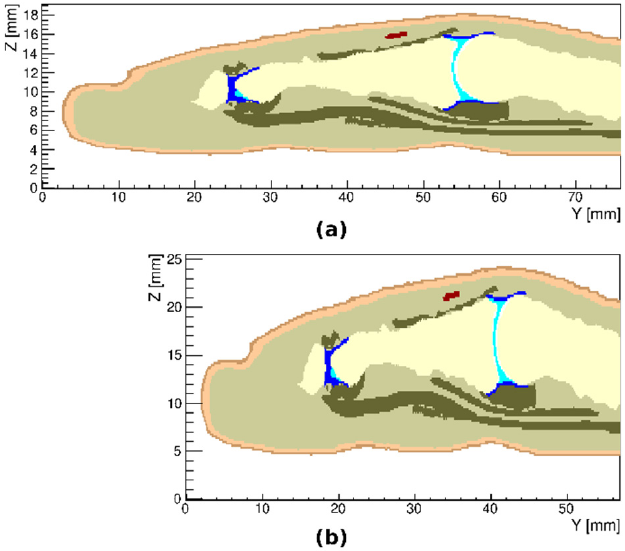
Figure 6. Sagittal cross sections of the model of an index finger, illustrating its tailoring to variations in geometry: scaled by 75% in the z-direction ( a ) and scaled by 75% in the y-direction ( b ).